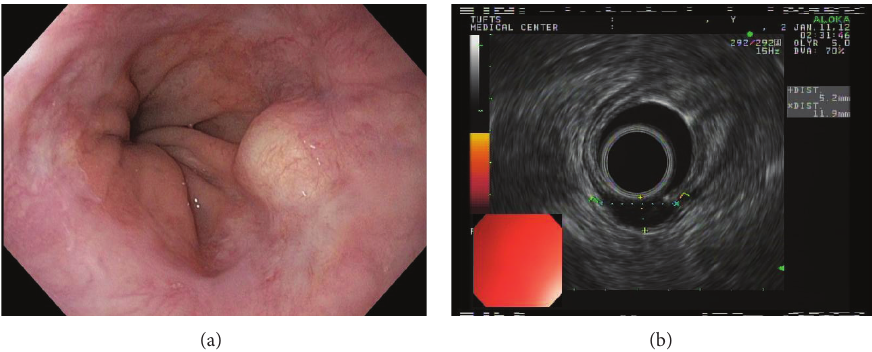
Figure 3: (a) Reappearance of submucosal nodule at the GE junction. (b) EUS: 11 mm × 5 mm nodule arising from the